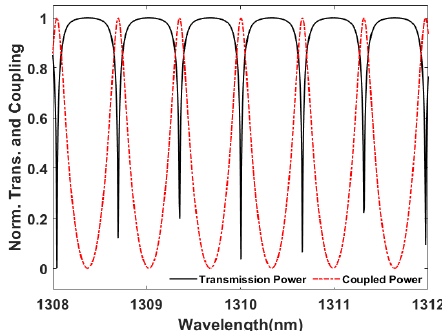
Figure 3. MRR spectrum from through and drop ports.